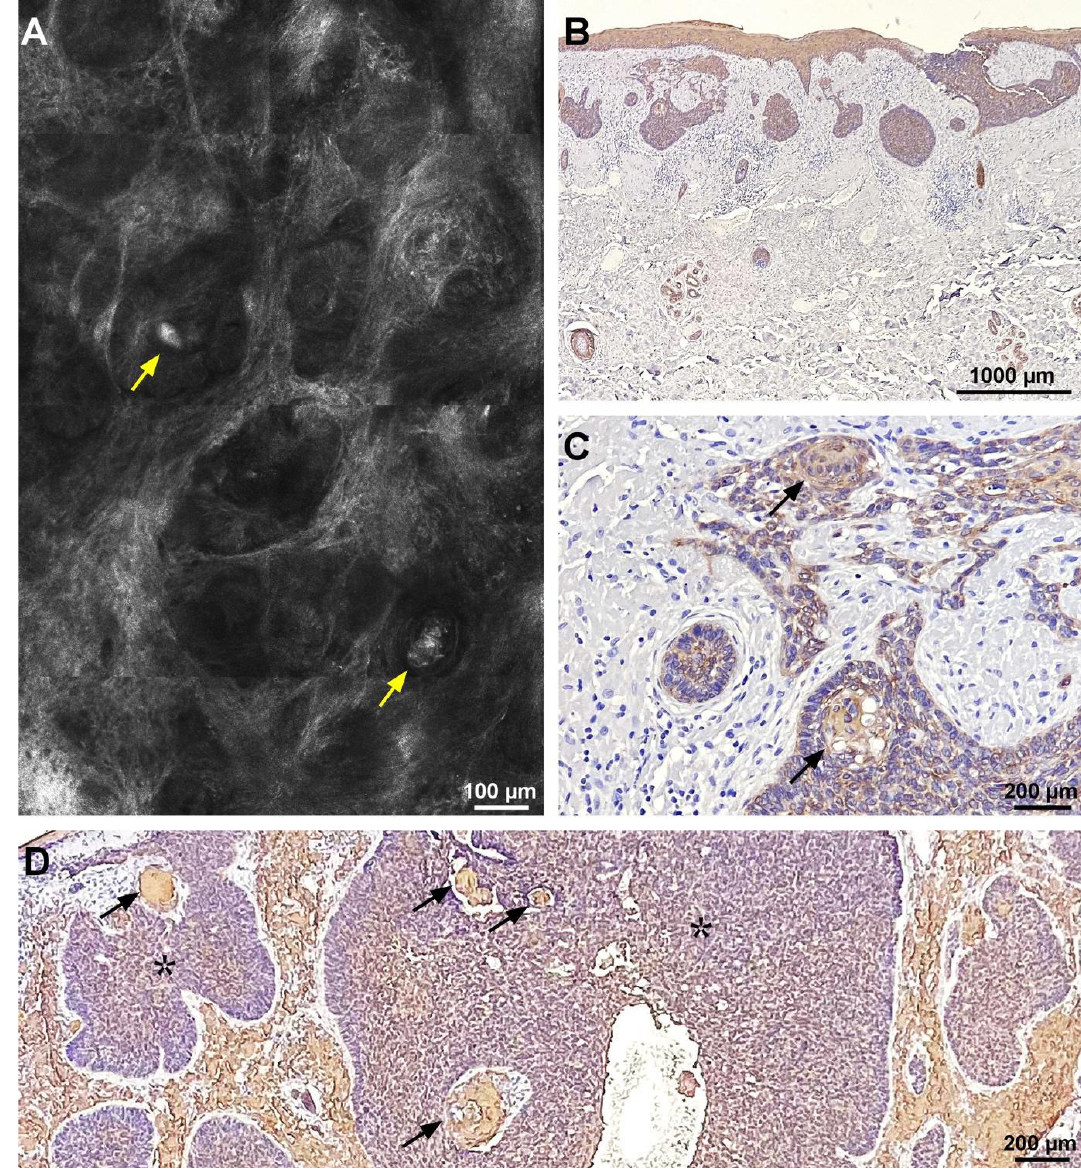
Figure 2. Correlation of reflectance confocal microscopy (RCM) image and CK34βE12 histological aspect of a nodular basal cell carcinoma (BCC). ( A ) RCM mosaic showing BCC tumor nodules with peripheral palisading and hyper-reflective globular structures within them (yellow arrows). ( B ) Histological image showing amyloid deposits stained in light brown (CK34βE12 stain). ( C ) Histology corresponding to panel ( A ) showing intra-tumoral amyloid deposits staining light brown (black arrows) (CK34βE12 stain). ( D ) Histological image displaying light brown, globular amyloid deposits (black arrows) inside BCC tumor islands (black asterisks) (CK34βE12 stain). RCM and histopathology images belong to the same case.